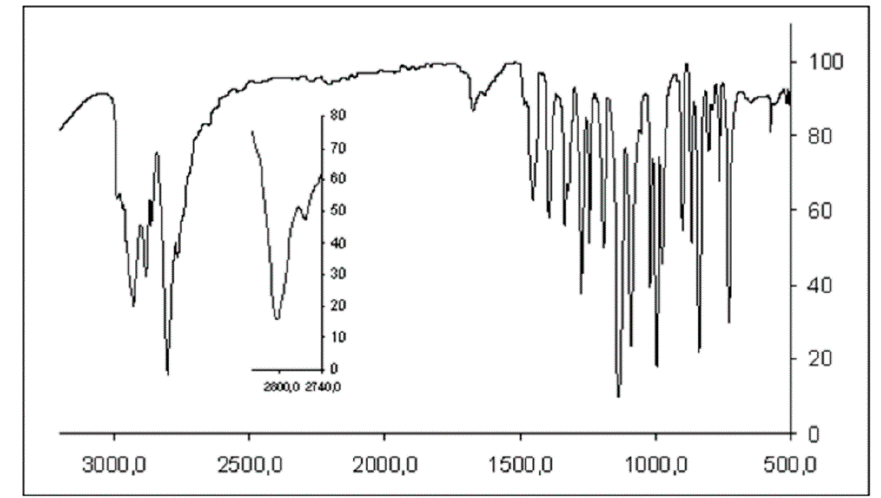
Figure 2. FT-IR spectrum of ETABOC.